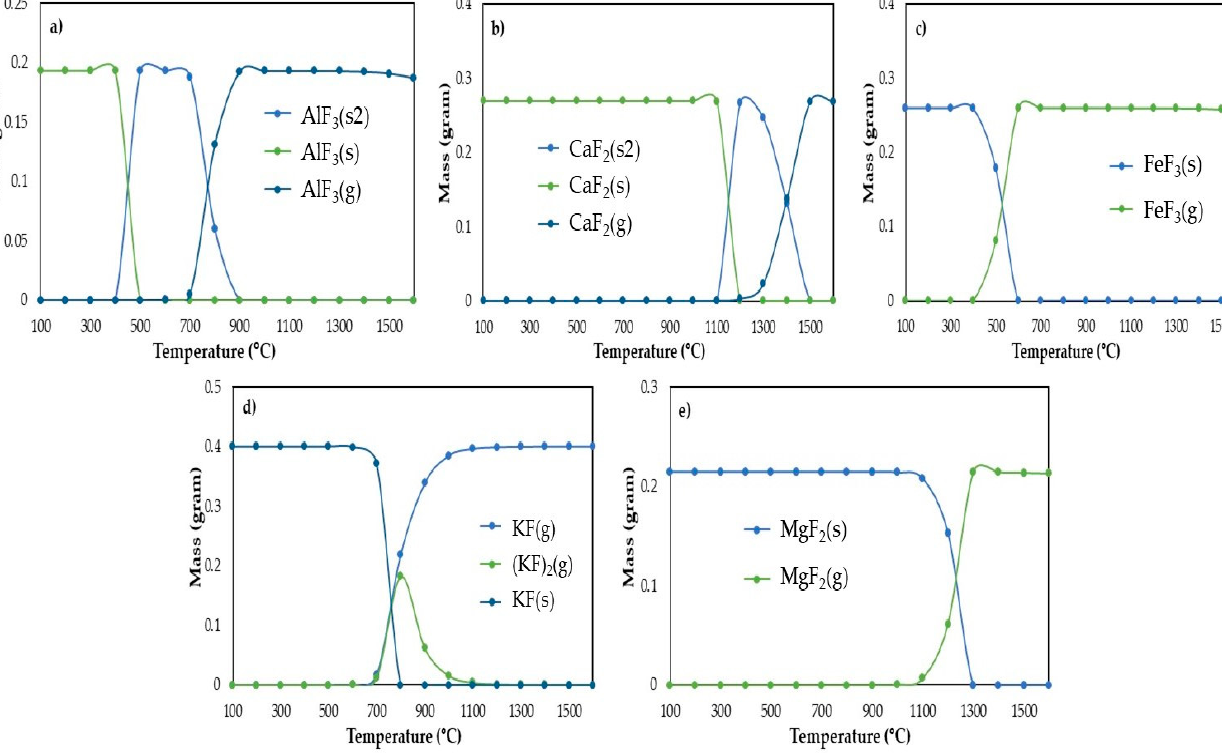
Figure 4. Equilibrium composition of F-Mineral oxides interactions during combustion: ( a ) F-O 2 -Al 2 O 3 ; ( b ) F-O 2 -CaO; ( c ) F-O 2 Fe 2 O 3 ; ( d ) F-O 2 -K 2 O, and ( e ) F-O 2